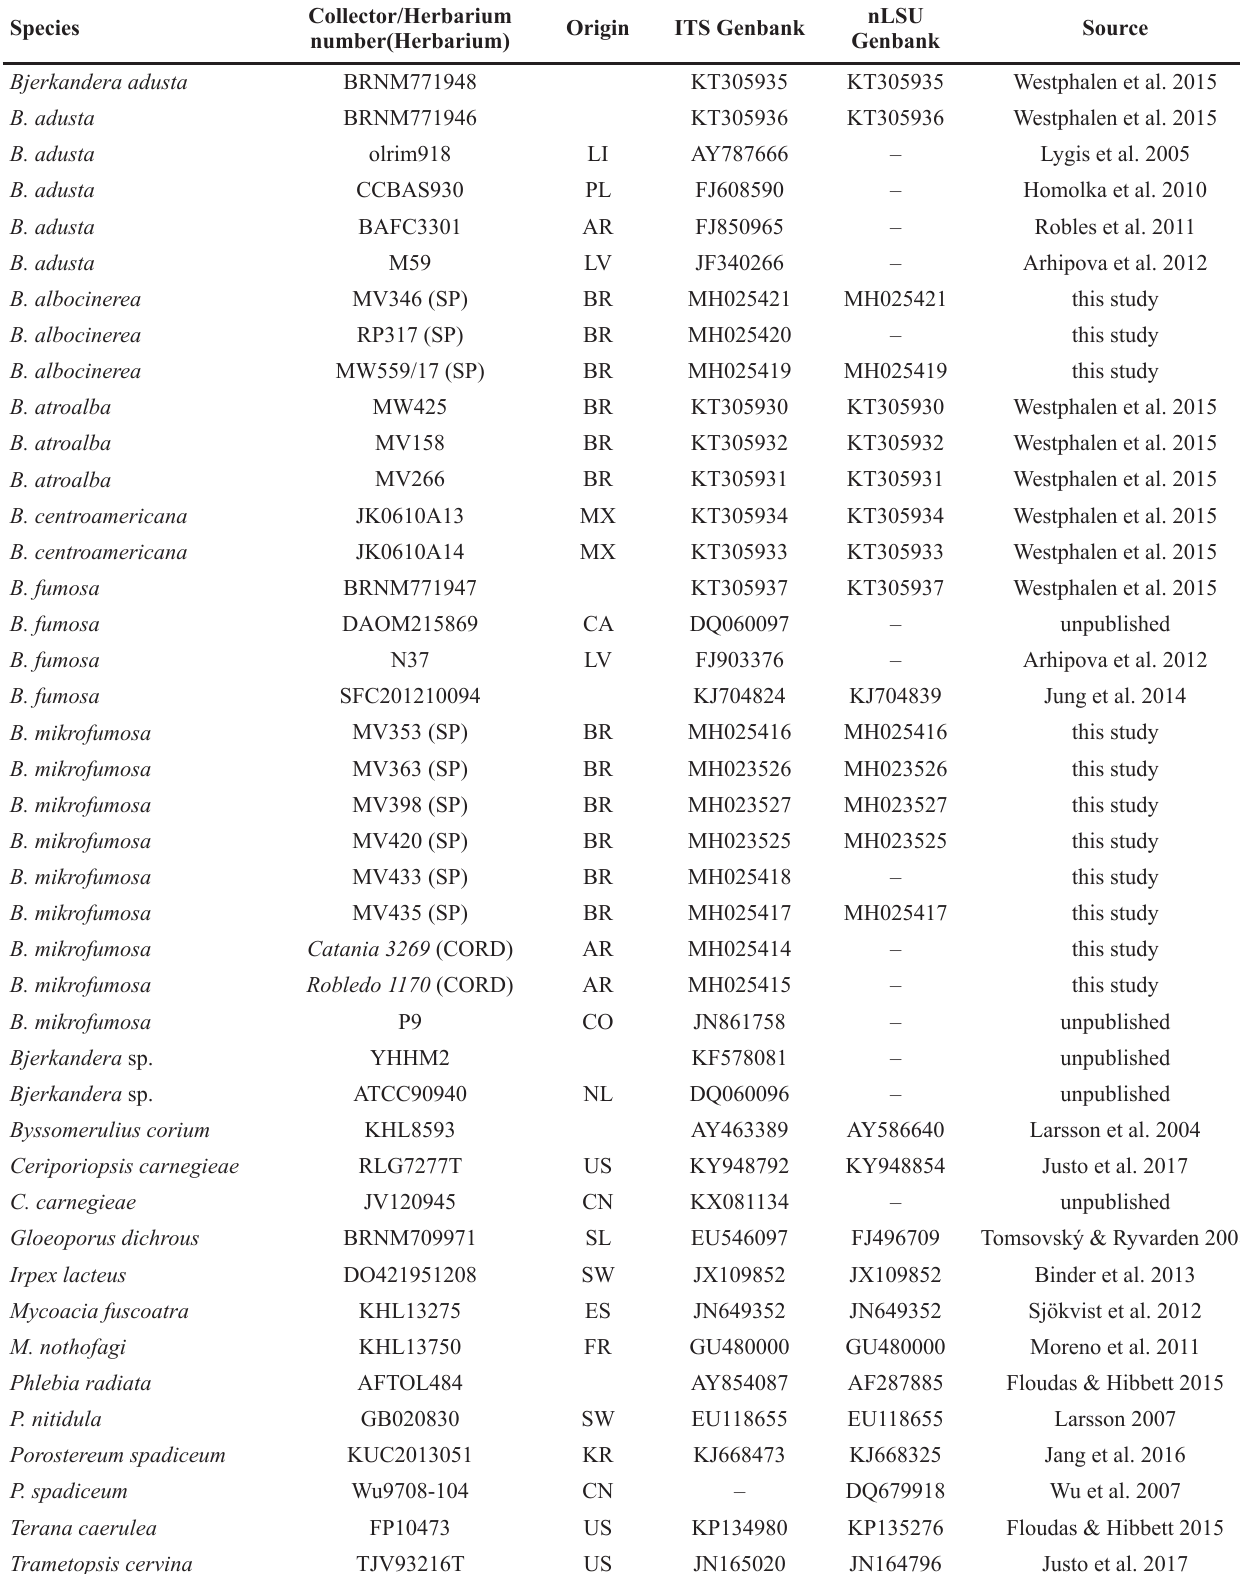
Table 1 – Data for ITS and nLSU sequences used in the phylogenetic analyses. Origin: ISO code